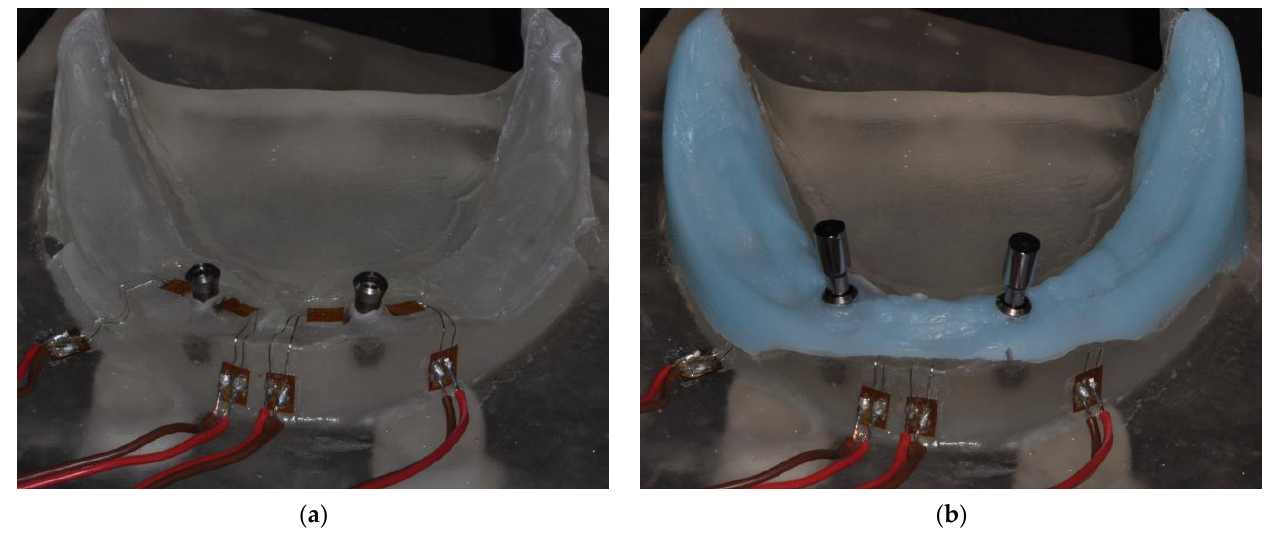
Figure 3. Existing patient situation with two interforaminal implants transferred to a resin model. ( a ) strain gauges were attached mesially and distally adjacent to the implants, capturing peri-implant strain development; ( b ) Model situation with gingival mask positioned and prototype abutments placed on the implants.